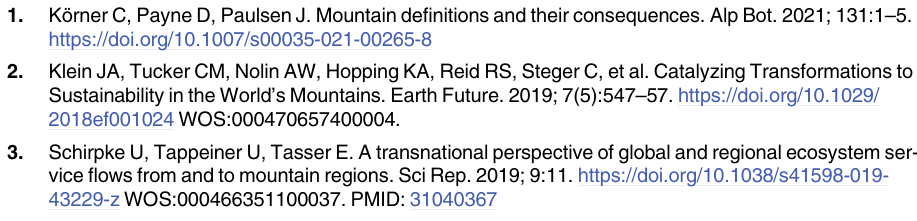
S4 Table. List of papers defined as mountain research by several authors of this study and evaluation results. S5 Table. Subsamples of results from queries with quality checks. S6 Table. List of selected words (including synonyms) analyzed within this study. S7 Table. Results of Trend Index as defined in this study for words, mountain ranges, countries and organizations. S1 Fig. Interactive world map with polygons of the 40 mountain ranges considered in this study. Range names are shown when moving the mouse over the polygons. S2 Fig. Differences due to geographical reference. Difference in population density of moun- tain ranges calculated for the entire polygon area and only for the rugged terrain within the polygon